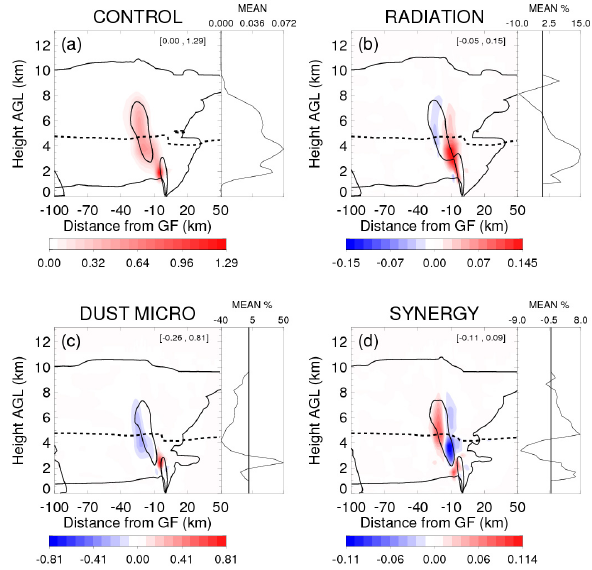
Fig. 12. Same as Fig. 10, except for the collision–coalescence rate (g kg − 1 5min − 1 ) between cloud and